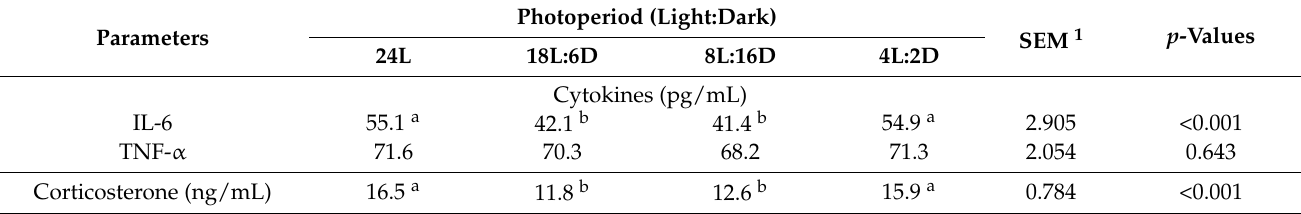
Table 5. Effect of photoperiod on cytokines and corticosterone concentration of